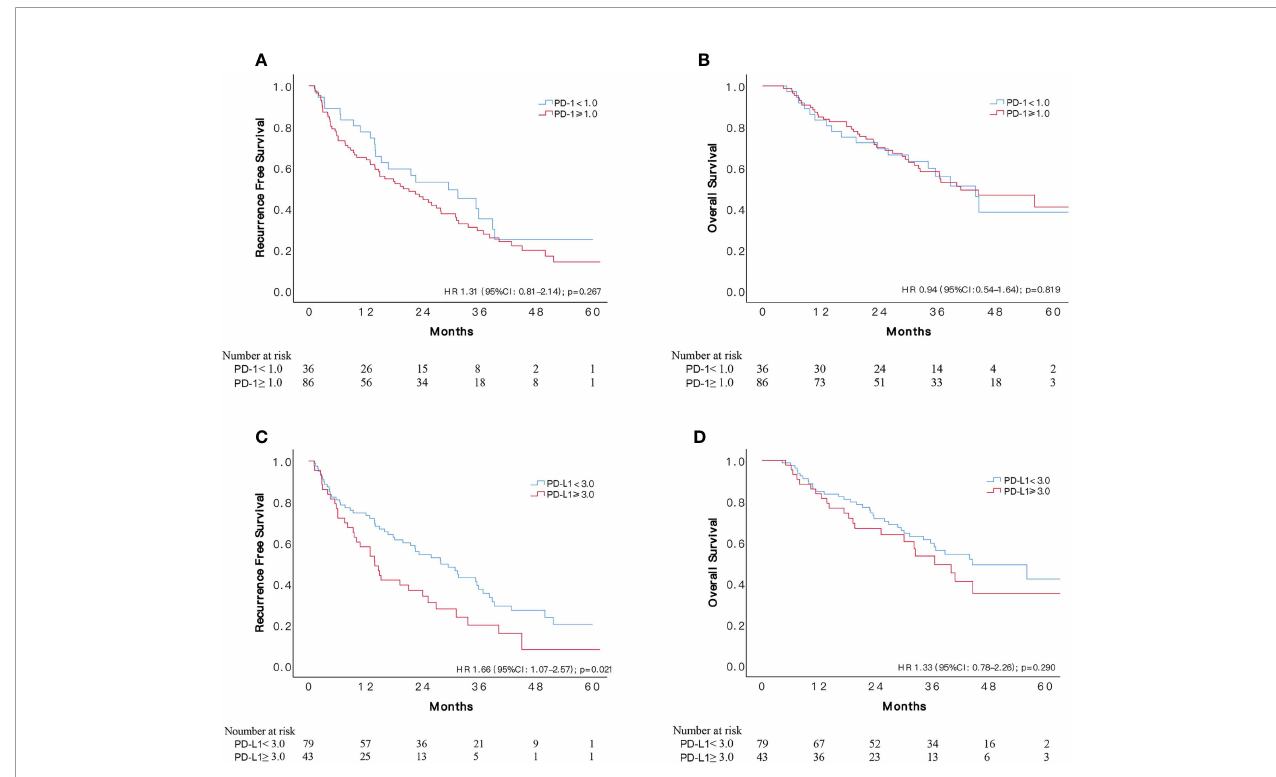
FIGURE 4 | Comparisons of survival among patients with different status of PD-1 and PD-L1 expression in 122 patients at high risk of recurrence who received adjuvant sorafenib. Kaplan – Meier curves of OS and RFS according to expression of PD-1 (A, B) and PD-L1 (C, D)